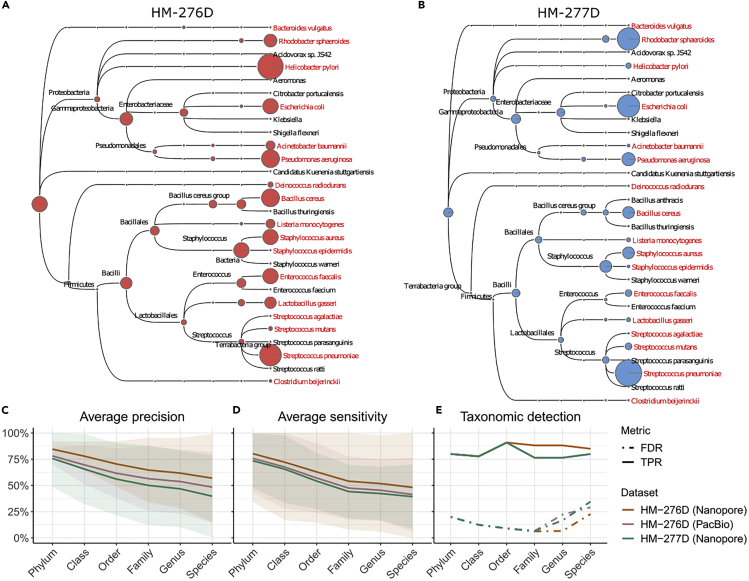
Taxonomic Binning Results for HM-276D and HM-277D Datasets(A and B) Megan taxonomic tree assignment obtained from HM-276D (A) and HM-277D (B) Nanopore sequenced datasets. Both datasets were downsampled to 160× depth of coverage. Each read was aligned against NCBI-nr protein reference database, then binned and visualized using Megan-LR. Megan taxonomic tree showing bacterial taxa identified and their corresponding abundances across taxonomic rank. The radius of circle represents the number of reads assigned for each taxon. Bacterial strains highlighted in red represent true organisms in the mock community.(C–E) Taxonomic binning and identification performance metrics across ranks based on different datasets (indicated by colors). Average precision (C), average sensitivity (D), and their 95% CIs were calculated based on metrics from different taxon at each rank. (E) Taxonomic detection accuracy metrics, true-positive rate (solid), and false-positive rate (dashed), were calculated based on identified taxon (reads >10) at each rank. To make fair comparison, each dataset was downsampled to 160× depth of coverage.